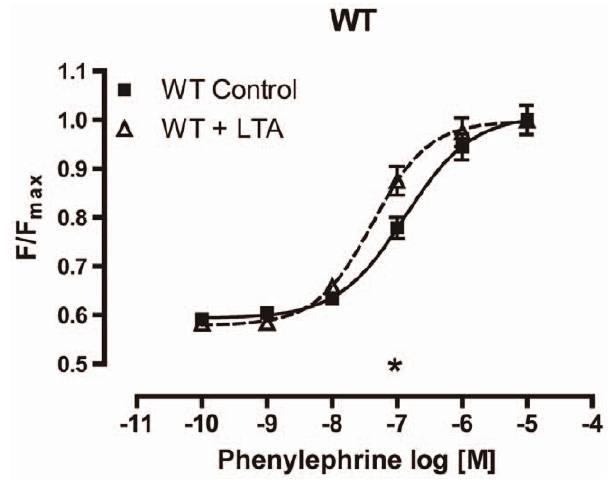
Figure 4. Influence of TLR2 agonism on aortic contractility. LTA application to WT mice increased contraction force at 10 2 7 M phenylephrine. Results were standardized to the maximum contraction force, which was not different between both groups (*p , 0.05; n $ 5 animals in each group; mean 6 SEM).